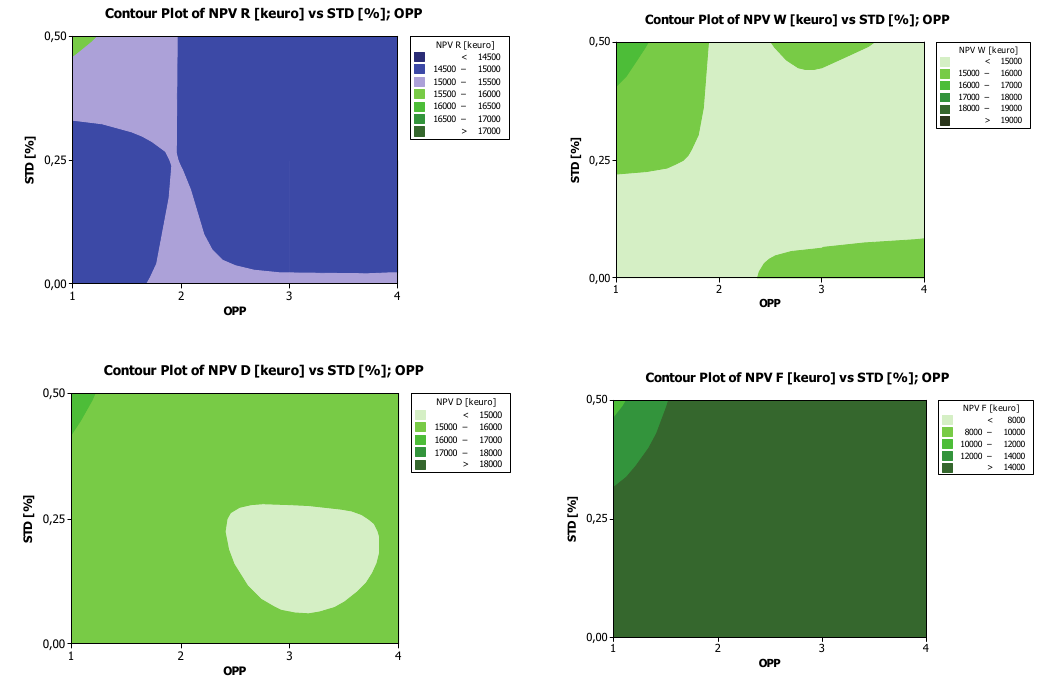
Fig. 9. Annuity Stream contour plot with different OPP location in: 1=RETAILER; 2=WHOLESALER; 3=DISTRIBUTOR; 4=FACTORY under different incidence of holding and stock-out (demand in small range)